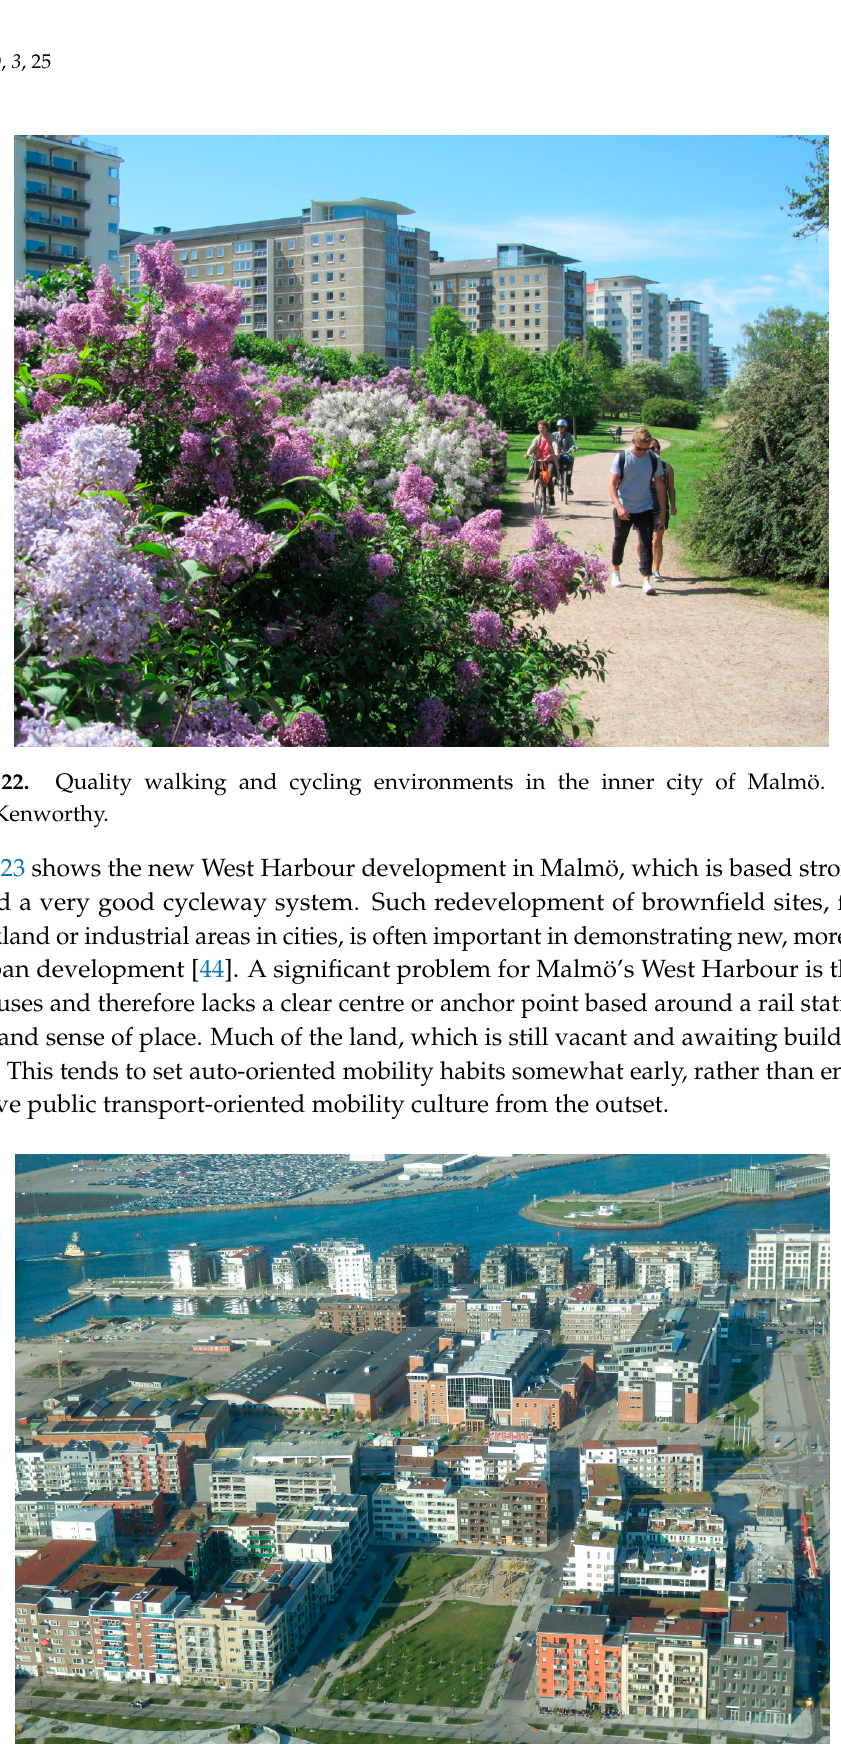
36 Figure 23. New urban redevelopment in Malmö’s West Harbour adds a new walking urban fabric, but lacks rail-based transport. Source: Jeffrey